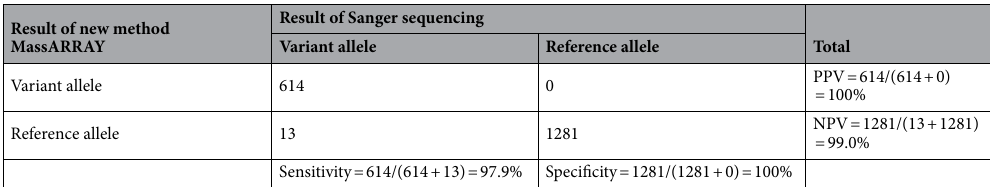
Table 2. Comparing the result of MassARRAY and Sanger sequencing in 1,908 tests. PPV: positive predictive values; NPV: negative predictive values.